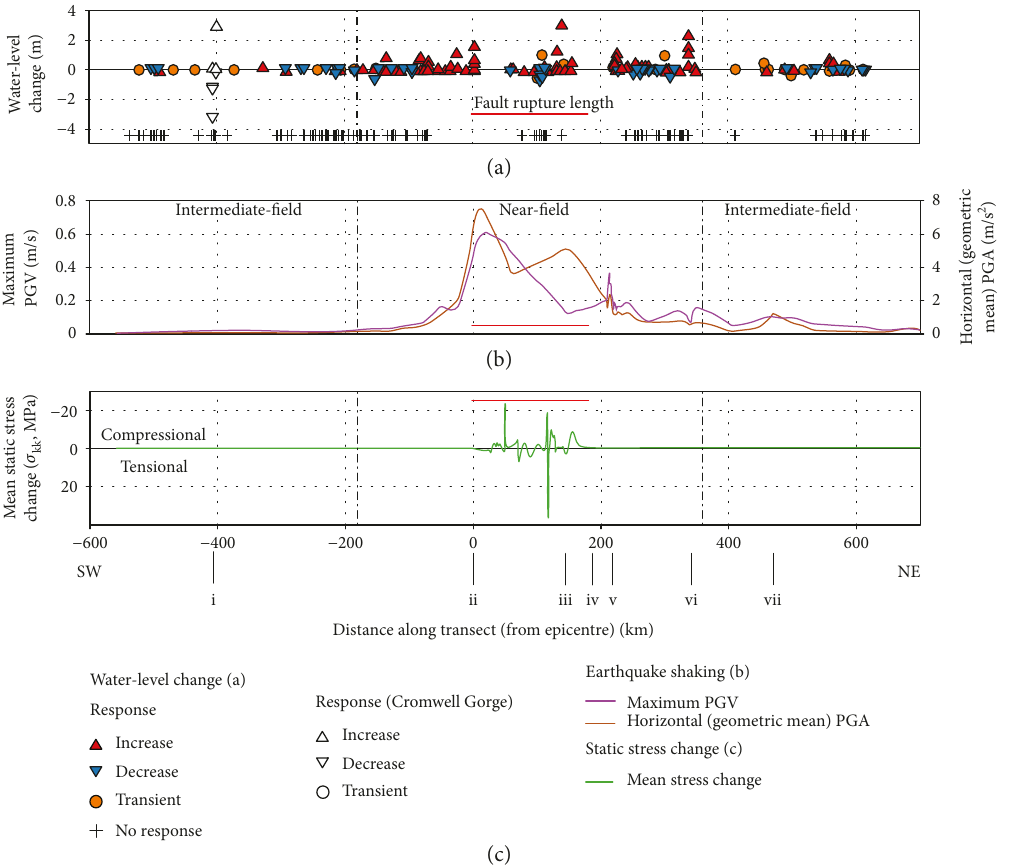
Figure 8: A cross section of the Kaik ō ura earthquake-induced (a) groundwater level changes, (b) maximum PGV and horizontal (geometric mean) PGA, and (c) mean static stress changes ( σ kk ). Locations of interest are (i) Cromwell Gorge monitoring wells, (ii) earthquake epicentre, (iii) Marlborough region, (iv) Cook Strait, (v) Wellington, (vi) Manawatu-Wanganui, and (vii) Hawkes Bay regions. The cross section goes through the Kaik ō ura surface rupture zone and the majority of monitoring